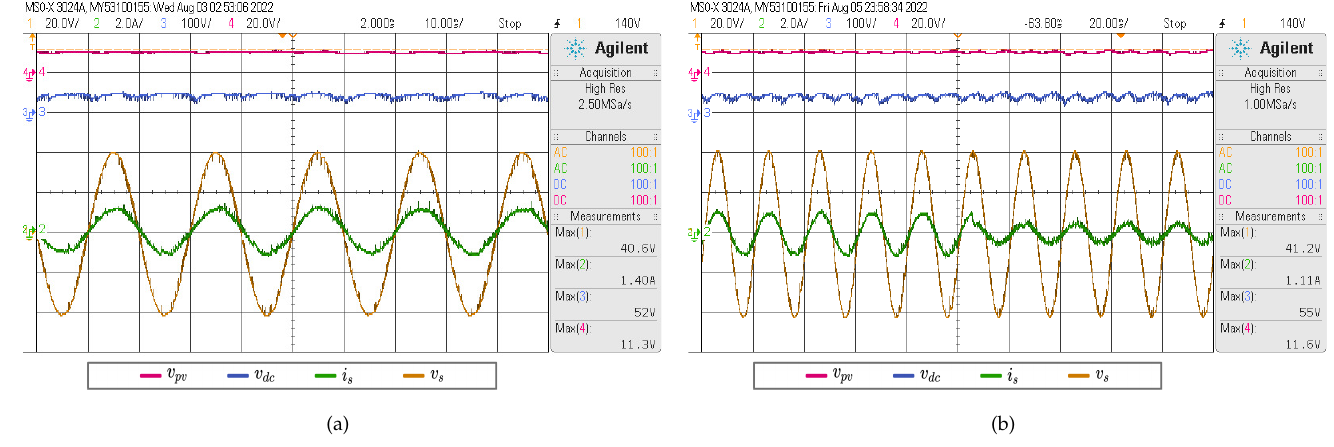
Figure 7. ( a ) Waveforms of voltage and current in the microinverter, ( b ) waveforms of voltage and current in the microinverter with change of the referent current.